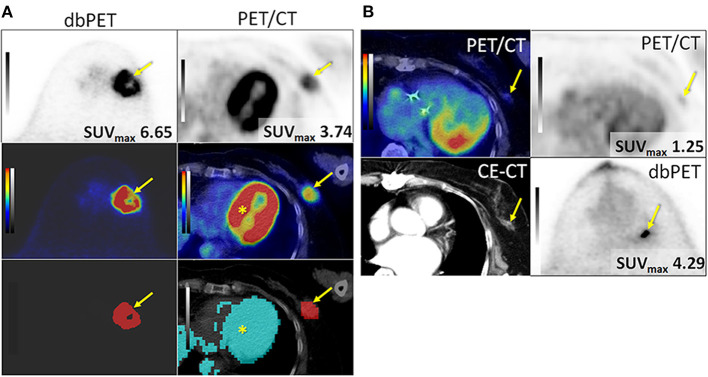
Successfully (A) and unsuccessfully (B) extracted breast cancers with dbPET and whole-body PET/CT. (A) Invasive ductal carcinoma in the left breast of an 84-year-old woman. BC (arrow) was successfully extracted with both dbPET and whole-body PET/CT (two images at the bottom) and clearly separated from the physiological uptake of the myocardium (*) with whole-body PET/CT. (B) Invasive ductal carcinoma in the left breast of a 74-year-old woman. It was successfully extracted with dbPET but failed with whole-body PET/CT; therefore, it was excluded from this study. BC, breast cancer; CE-CT, contrast-enhanced computed tomography; dbPET, dedicated breast positron emission tomography.